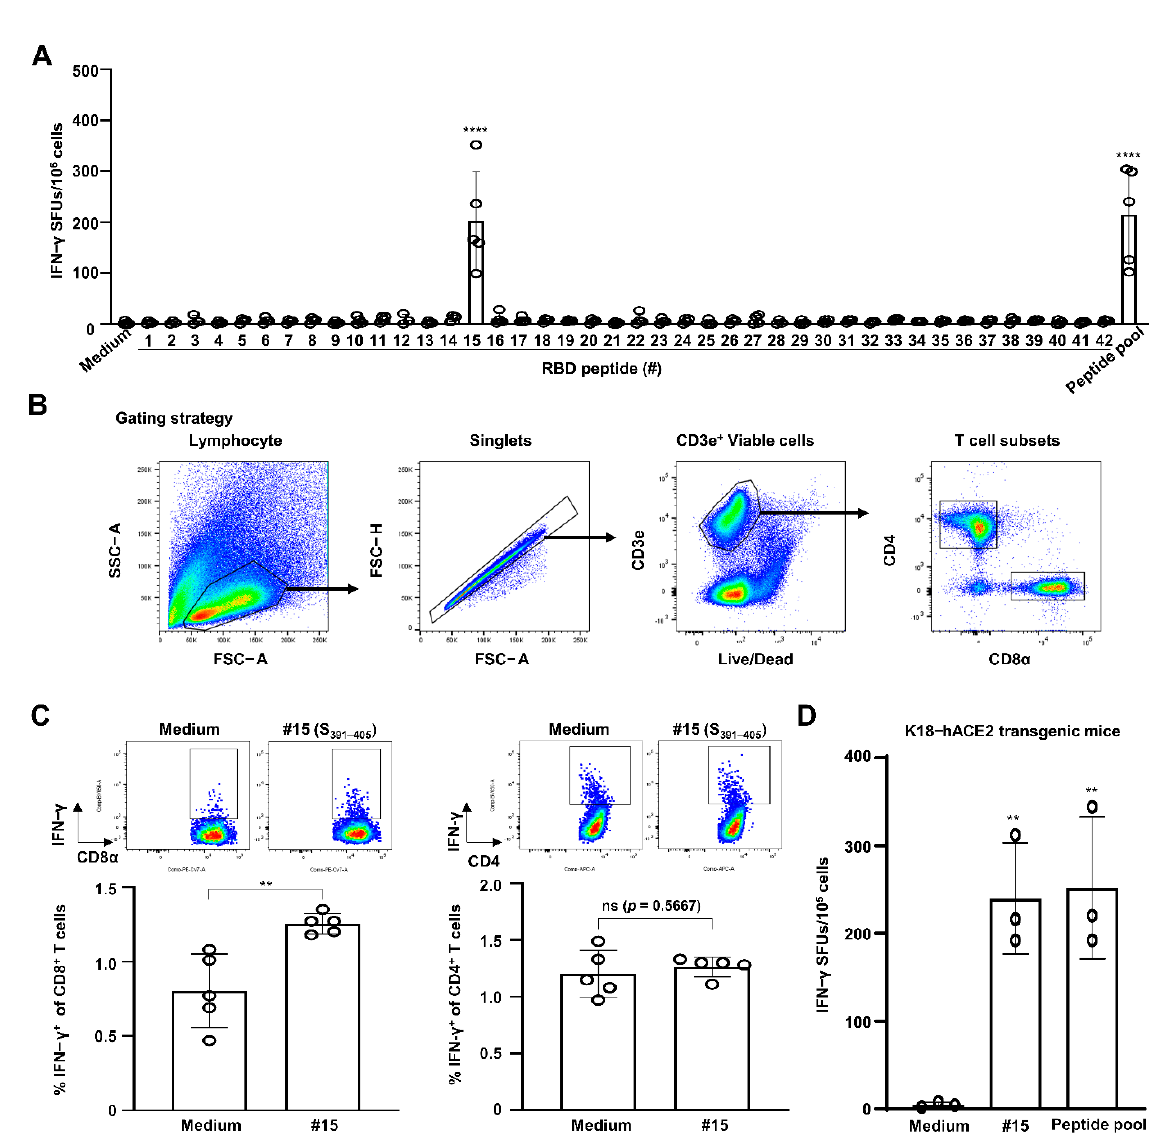
Figure 1. SARS-CoV-2 S 391–405 elicits IFN- γ production by CD8 T cells in splenocytes of SARS-CoV-2 S-RBD